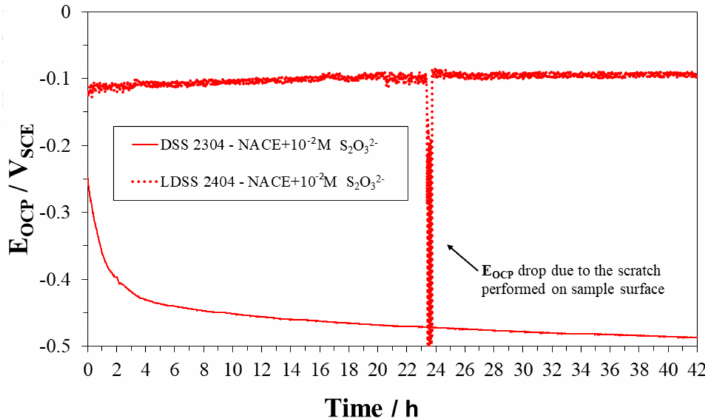
Figure 14. E OCP -time trends of DSS 2304 and LDSS 2404 during immersion in NACE TM-0177 solution at 25 ◦ C and pH 2.7, in the presence of 10 − 2 M S 2 O 3 2 −